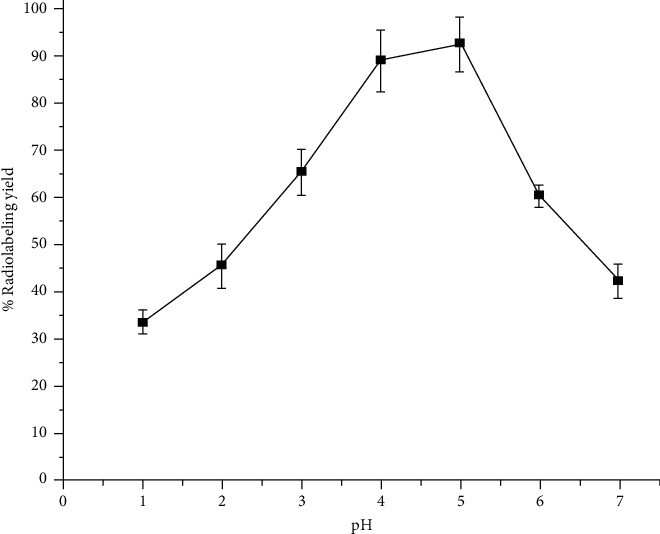
Variation of % radiolabeling yield of 177Lu-acridine complex with pH.